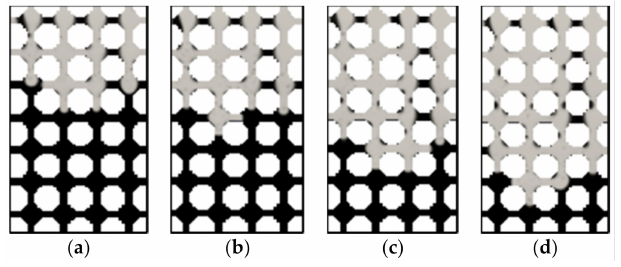
Figure 9. Pore-invasion in VAPEX process as a function of time in the simulation. ( a – d ) are time 8000 s, 8100 s, 8200 s, and 8300 s. The black and grey colors show oil and solvent phases, respectively, and the white shapes are grains.